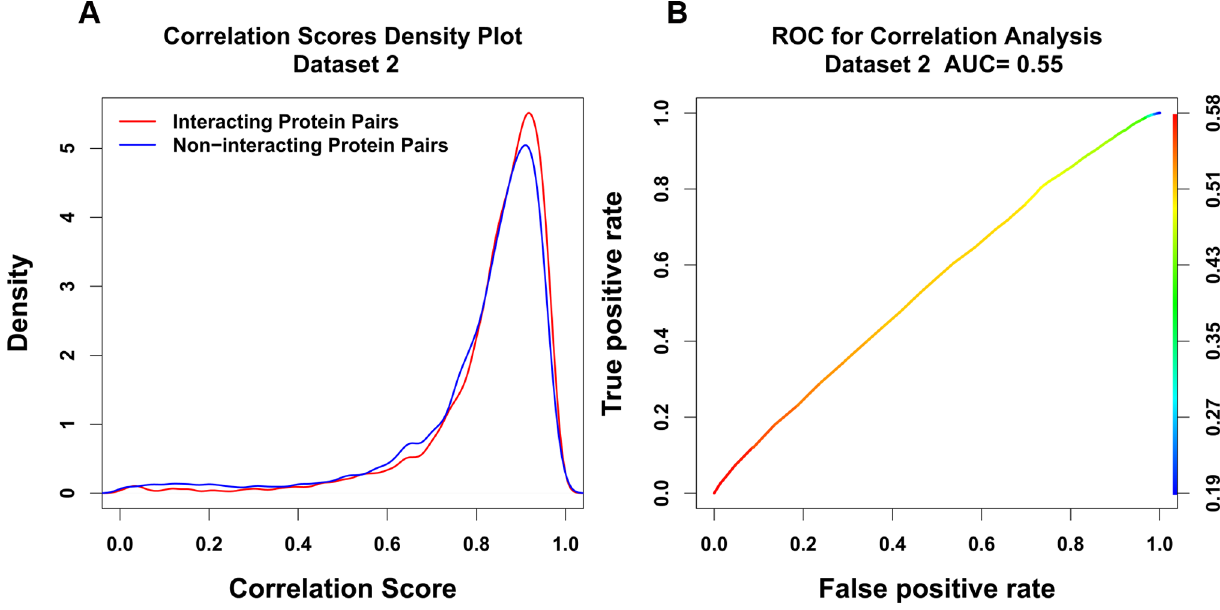
Figure 2. Density plot for correlation scores using Jones-Taylor-Thornton matrix for common interacting and non-interacting protein pairs from Dataset 2 (A) and the corresponding ROC plot (B).